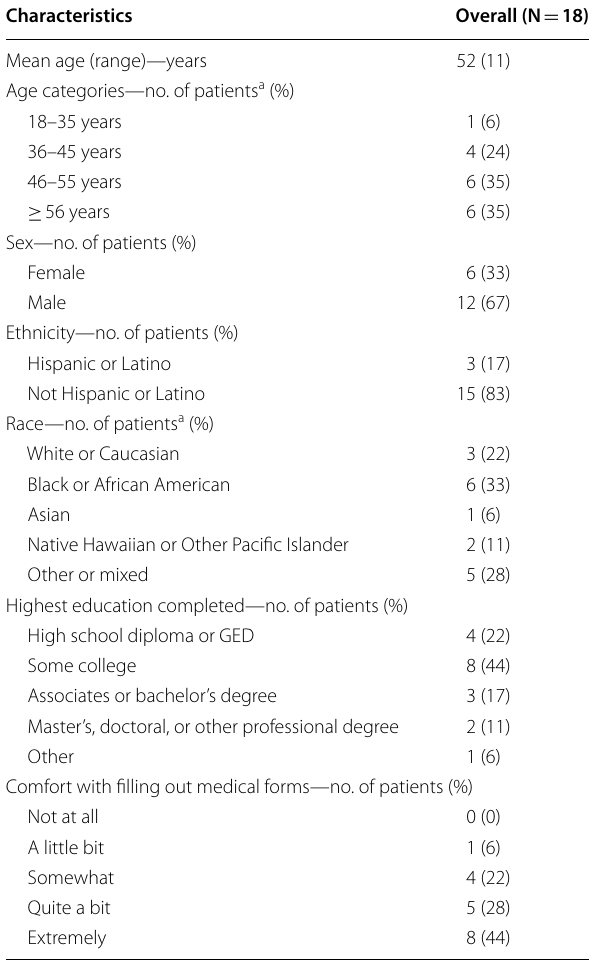
Table 1 Cognitive interview participant